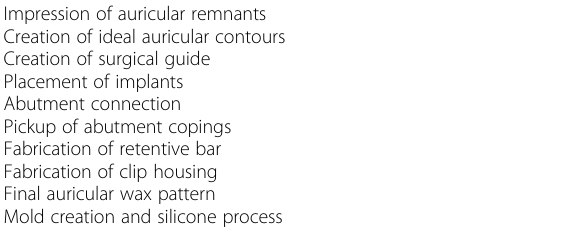
Table 1 Sequence of treatment procedures Impression of auricular remnants Creation of ideal auricular contours Creation of surgical guide Placement of implants Abutment connection Pickup of abutment copings Fabrication of retentive bar Fabrication of clip housing Final auricular wax pattern Mold creation and silicone